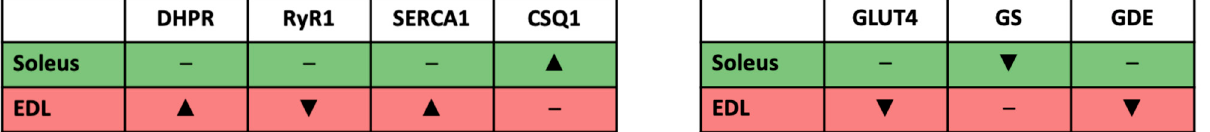
Figure 5. Summary diagram of myofiber ‐ type specific differences in protein levels related to Ca 2+ handling (i.e., excitation ‐ contraction coupling) and glucose/glycogen metabolism for dysferlin ‐ deficient BLAJ muscles. ( A ) Simplified diagram indicating location and direction of change (arrows) of affected proteins, for male BLAJ slow soleus (shown in green) and fast EDL (shown in red) muscles, relative to WT mice, aged 10 months ( n = 1–6). ( B ) Summary emphasizing relative changes in these protein abundances ( ▲ , ▼ , – indicate an increase, decrease, or no change, respectively). Abbreviations: